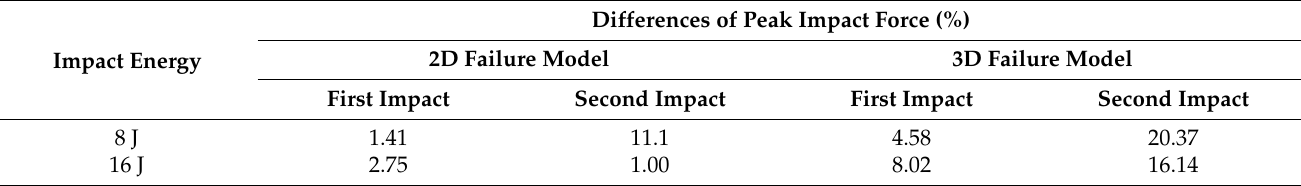
Figure 17. Multiple impact force-time curves. Comparison of experimental and simulation results for GLARE 5-2/1 under impact energy of 16 J. Table 7. Difference between predicted and measured peak impact force for GLARE 5-2/1 Impact Energy